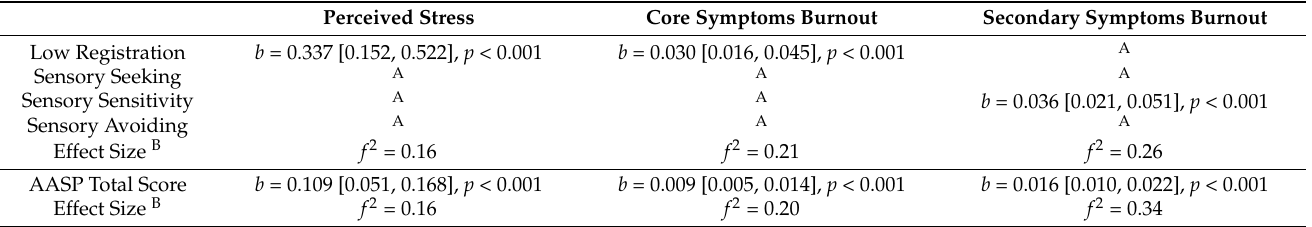
Table 5. Multiple regression models with AASP raw quadrant and total scores, and stress- and burnout-related total scores in healthy